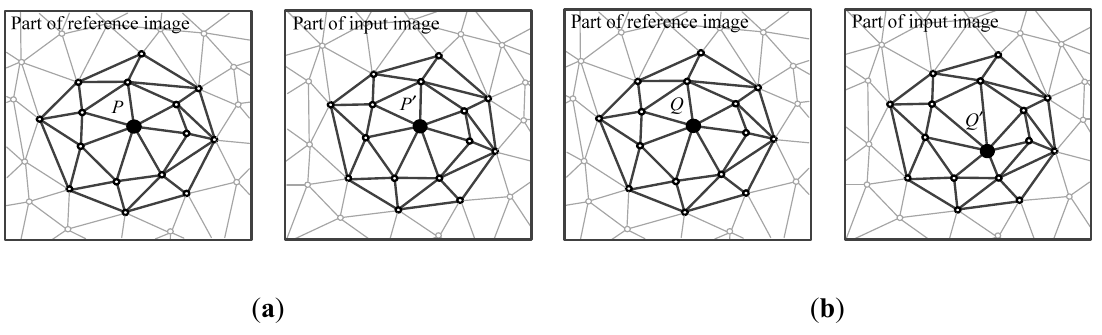
Figure 2. Analysis of false match identification. ( a ) Correct match. ( b ) False